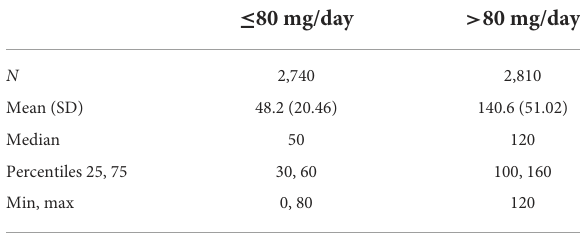
TABLE 2A Last recorded dose for the overall